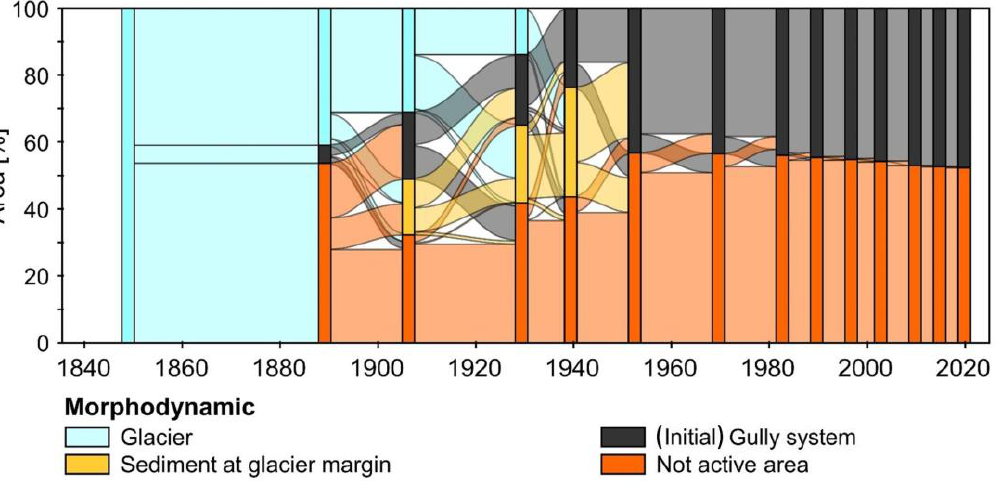
Figure 6. Changes in morphodynamic types of the AoI from 1890 to 2020 (For reasons of visualisation, the 1969 and 1982 mappings were excluded from this figure, which can be, however, found in the Appendix D, Table A6).